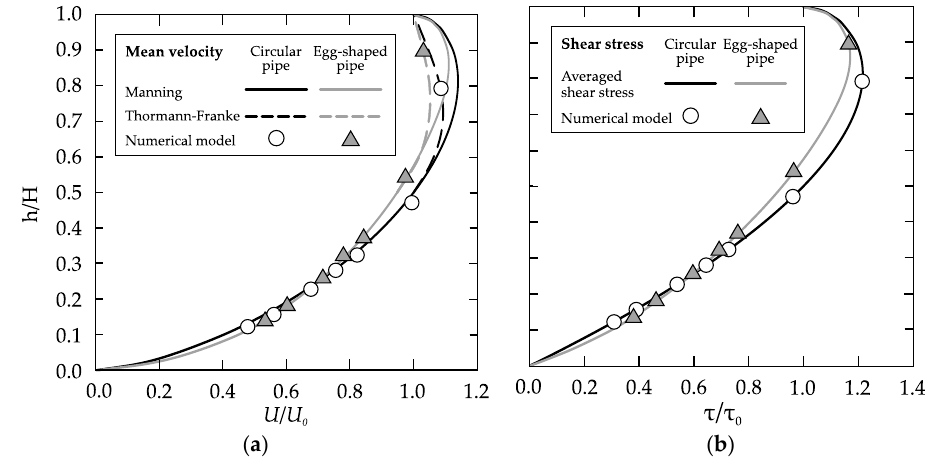
Figure 5. ( a ) Averaged velocity and ( b ) shear stress comparison of numerical results for circular (circles) and egg ‐ shaped (triangles) cross ‐ sections with Manning (continuous line) and Thormann ‐ Franke (dashed line) formulas. Axes are normalized with the height of each conduit (H) and their full ‐ depth mean velocity ( U 0 ) and averaged shear stress ( τ 0 ), respectively.